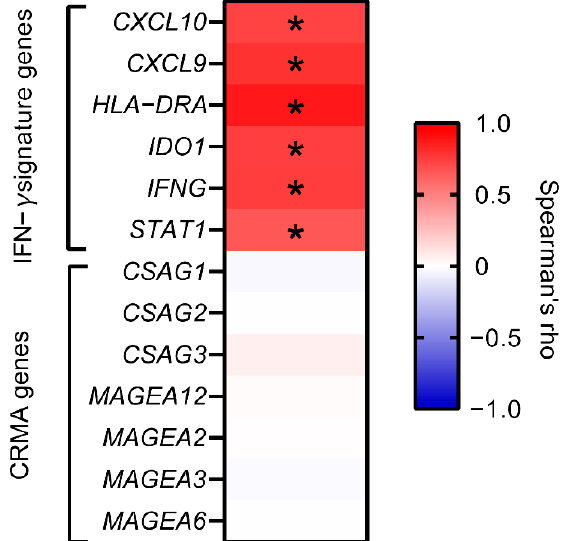
Figure 5. Spearman correlation of EVI2B gene expression with the IFN- γ related six genes ( IDO1 , CXCL10 , CXCL9 , HLA-DRA , STAT1 , and IFNG ) and the CRMA gene signature ( CSAG1 , CSAG2 , CSAG3 , MAGEA2 , MAGEA3 , MAGEA6 , and MAGEA12. * p < 0.05.